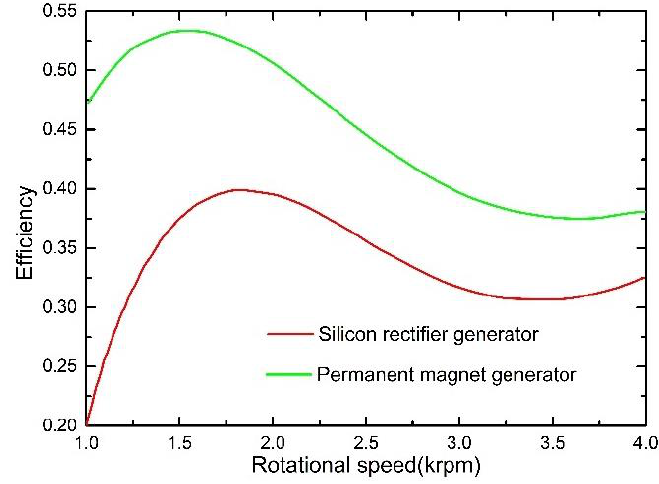
Figure 1. Comparison of efficiency characteristic curves between permanent magnet generator and silicon rectifier generator.